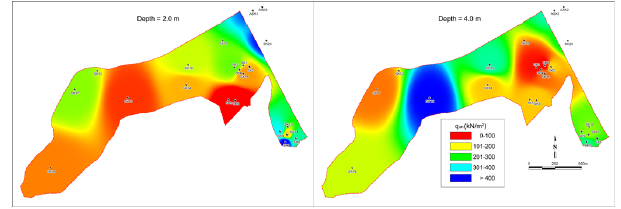
Fig. 11. Unconfined compressive strength zonation map of the study area.